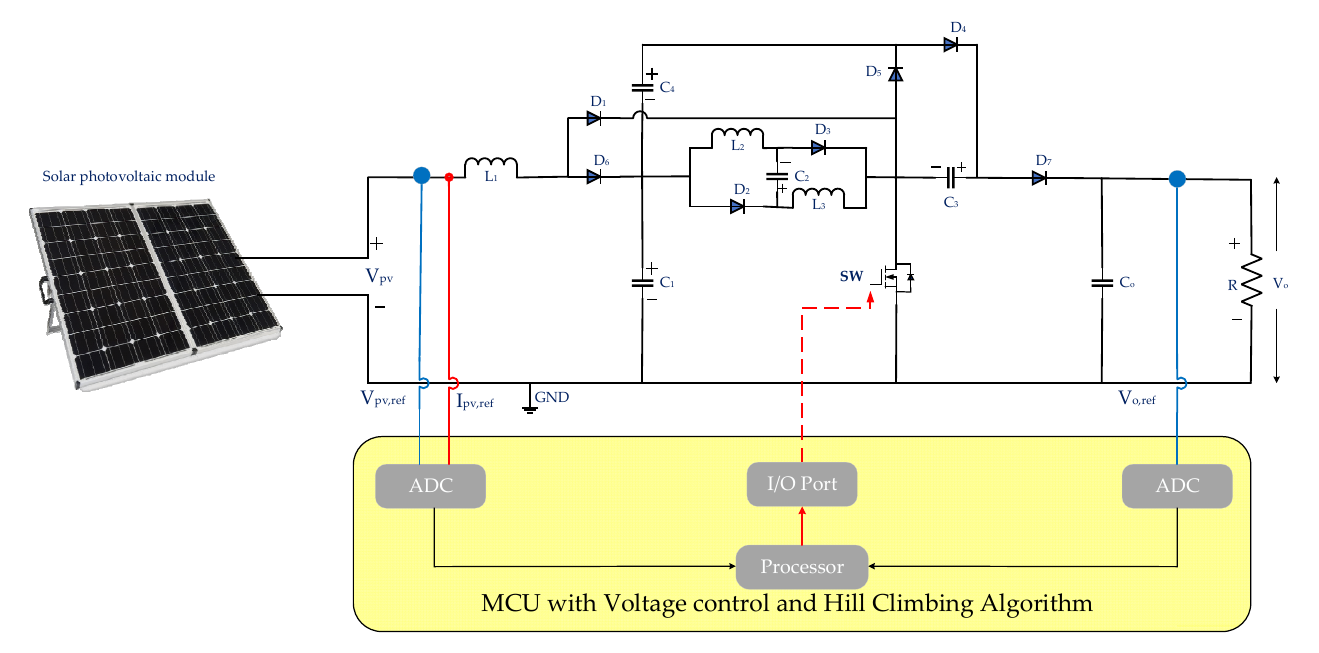
Figure 14. Structural block diagram of the proposed HVGSU converter embeds with the hill climbing control strategy. Table 3. The component speci fi cations used in the hardware prototype of the proposed converter.